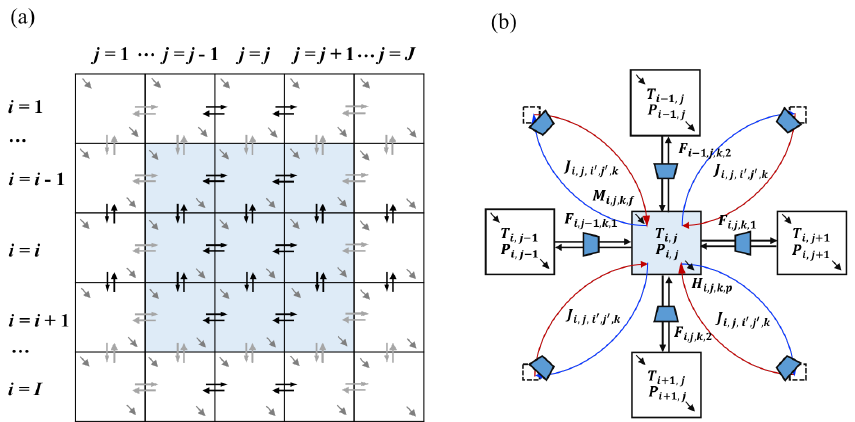
Figure 2. Construction of superstructure for fuel gas synthesis problems: ( a ) Block superstructure illustration; ( b ) Block interaction via connecting streams (blue line: jump connecting flow from the block B i , j ; red line: jump connecting flow into the block B i , j ; blocks at diagonal positions are ignored for